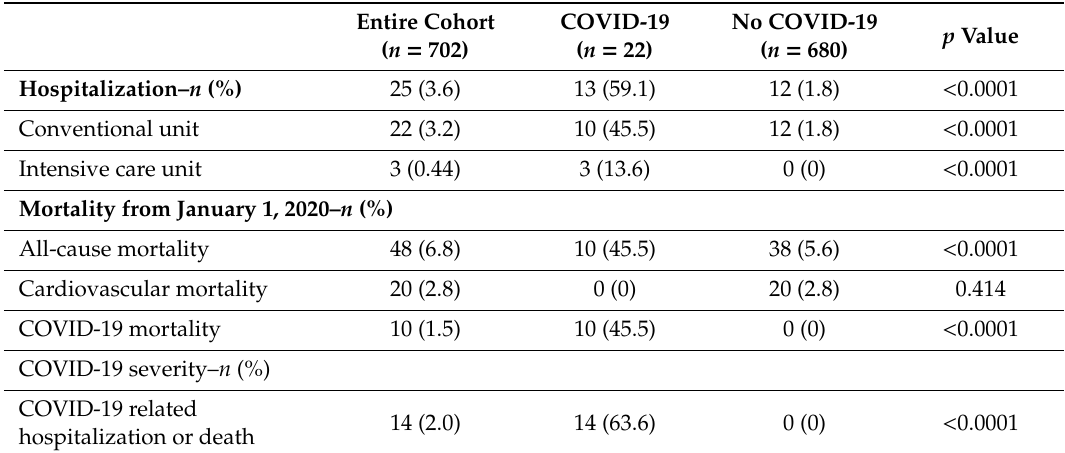
Table 2. Clinical outcomes of patients who had undergone transcatheter aortic valve replacement according to the presence or absence of